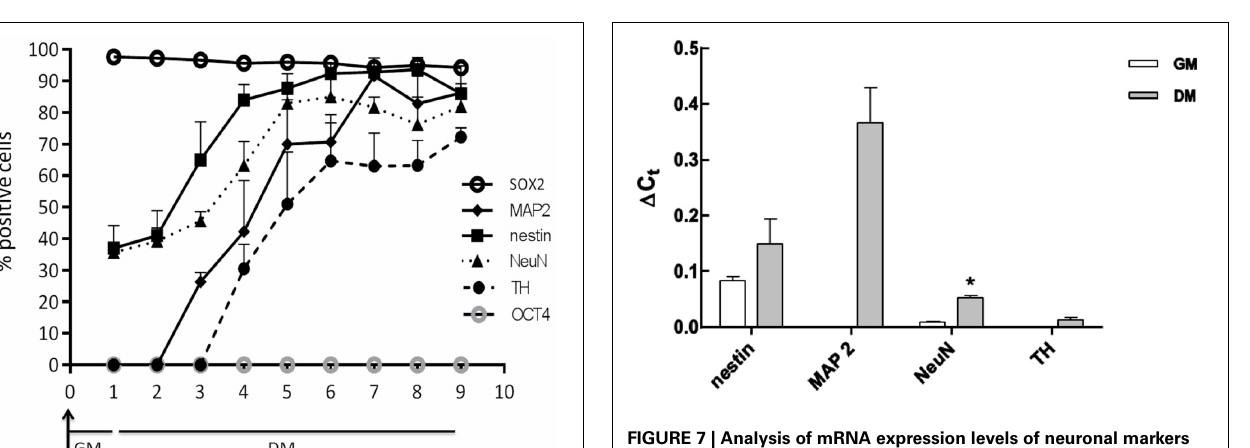
FIGURE 7 | Analysis of mRNA expression levels of neuronal markers using qRT-PCR in non-differentiated and differentiated LUHMES. Expression was normalized to GAPDH mRNA expression. Data from five independent experiments are expressed as mean ± s.e.m. ∗ P < 0 .